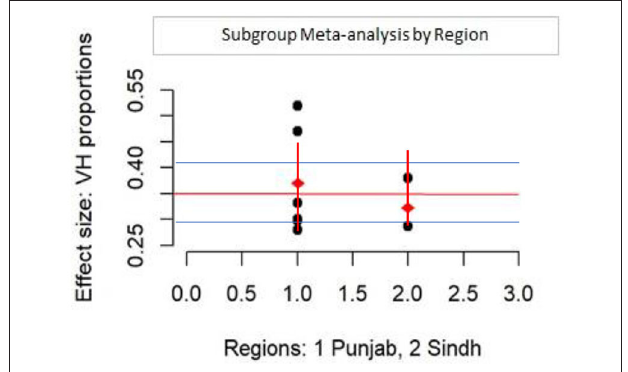
FIGURE 2 | Subgroup analysis by dominating region.